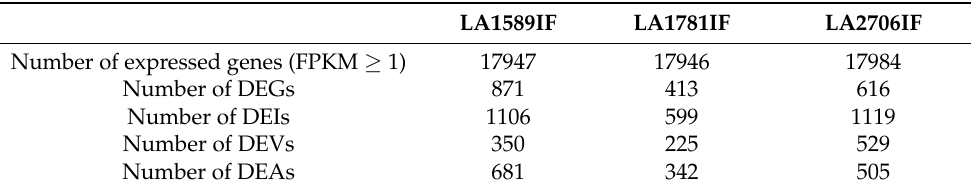
Table 2. Summary of differentially expressed splice variants, isoforms and genes in the inflorescences under PG and OF conditions.